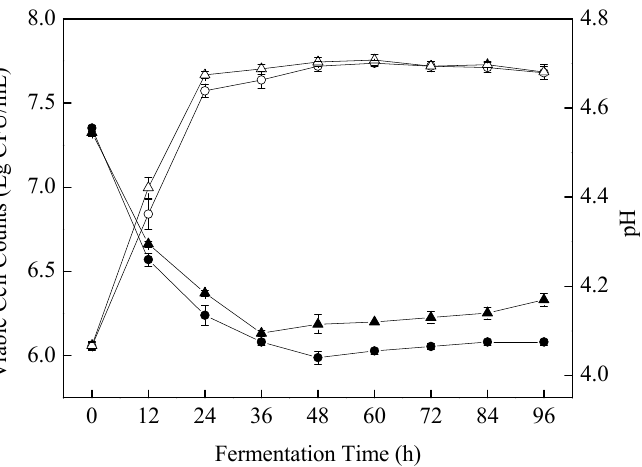
Figure 1. Viable cell counts and pH values were measured during 96 h of apple juice fermentation. The  and △ indicate the viable cell counts in S. cerevisiae SC125-fermented apple juice and the control. The  and  indicate pH value of the S. cerevisiae SC125-fermented apple juice and the